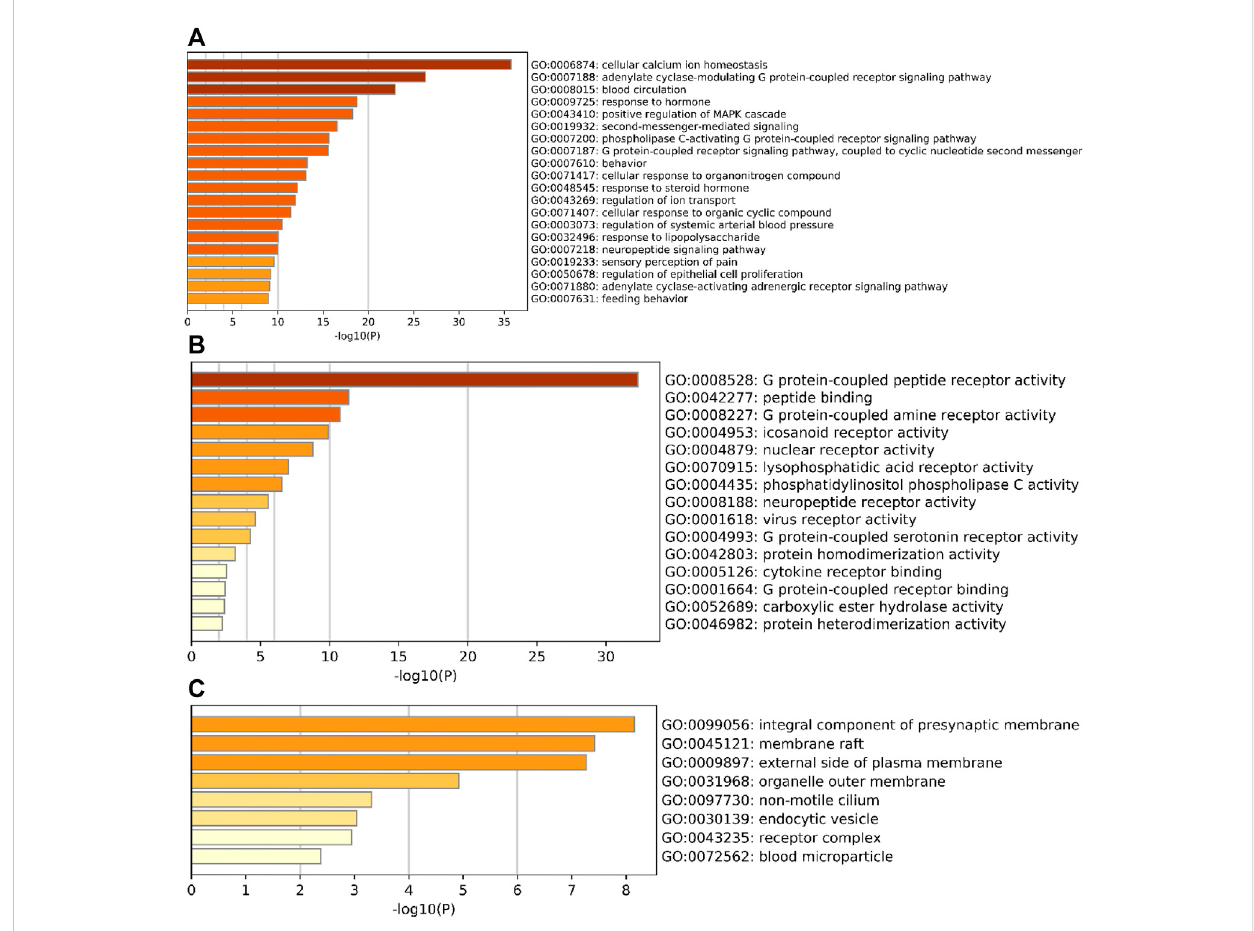
FIGURE 7 Bar graph of GO gene function annotation. (A) BP, (B) MF; (C) CC. horizontal coordinates represent p -values taken at log base 10, vertical coordinates represent GO entry names, and colors from light to dark represent the degree of signi fi